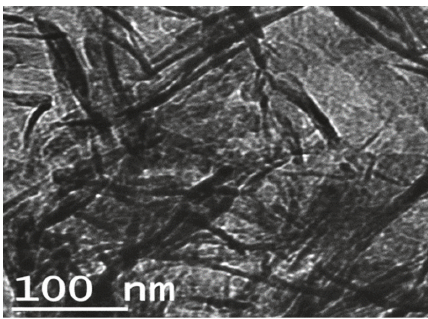
Figure 2: TEM micrographs of hydroxyapatite nanoparticles syn- thesized from